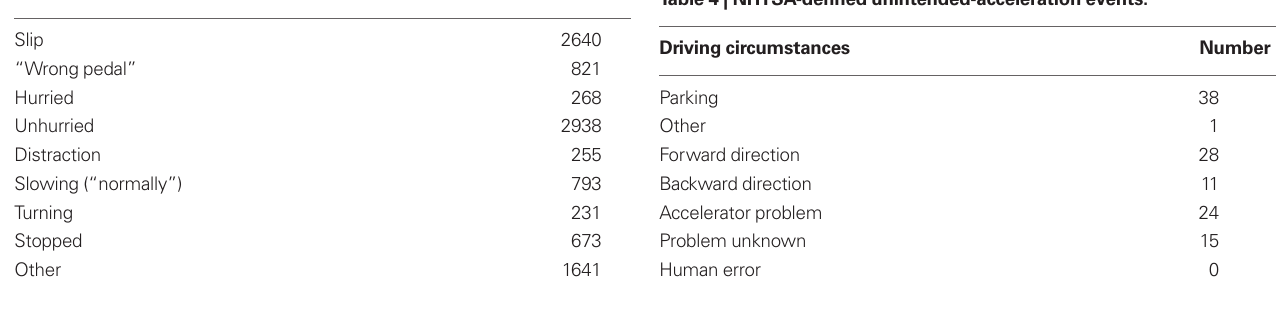
Table 4 | NHTSA-defined unintended-acceleration